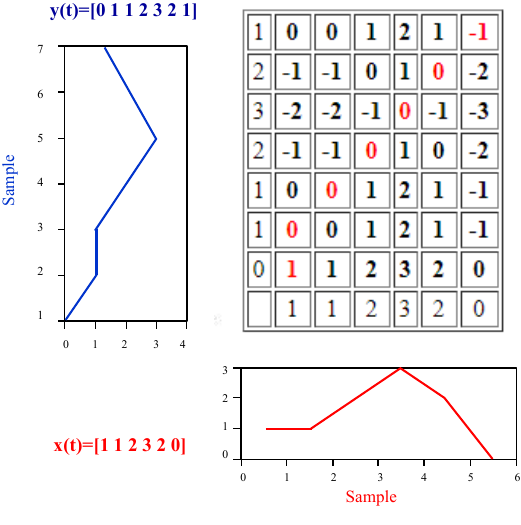
Figure 4. The process of dynamic time warping.